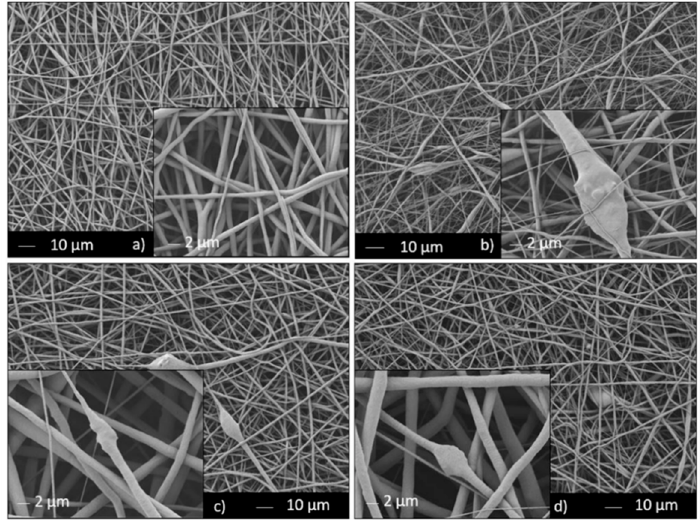
Figure 2. SEM analysis of electrospun mats: PCL ( a ), PCL_45S5 ( b ), PCL_BG10 ( c ), and PCL_BGZn ( d ).